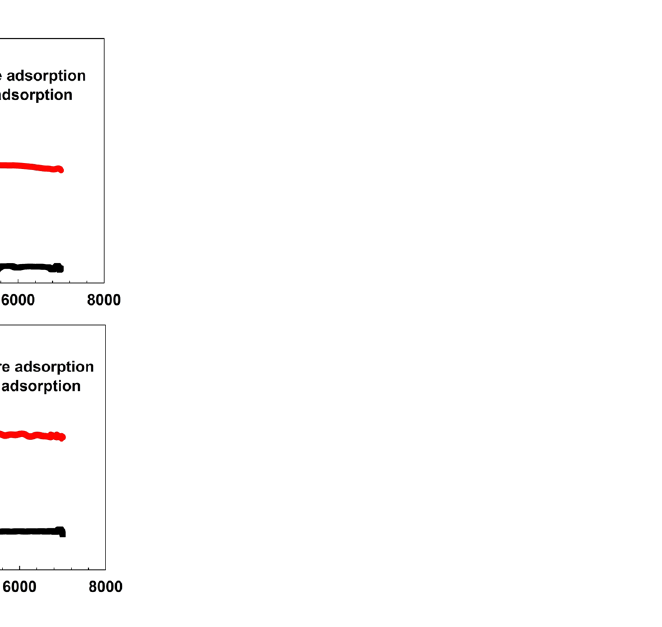
Figure 14. Chronoamperometric response of ( A ) LDH without calcination and ( B ) sample calcined at 200 °C under optimum